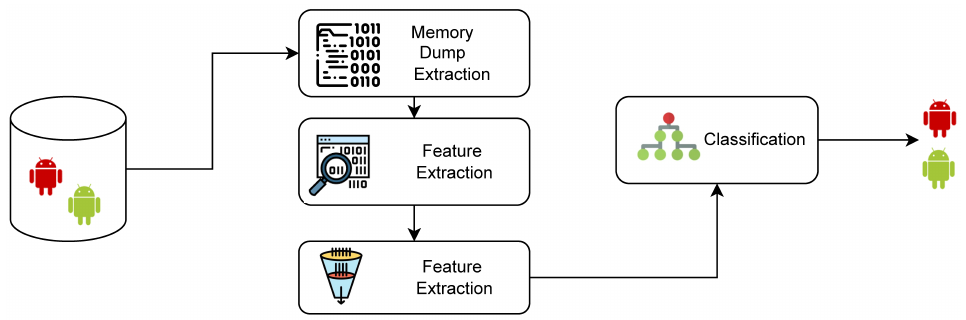
Figure 1. KTSODroid: flow of